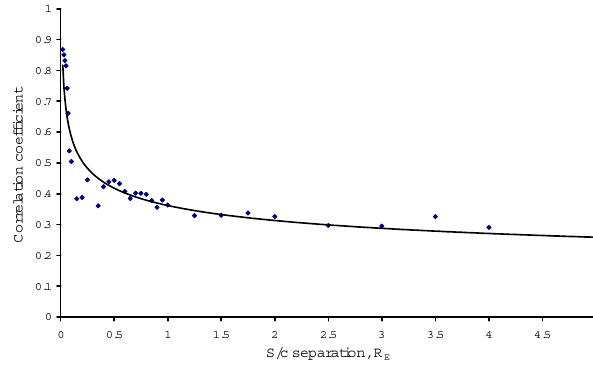
Fig. 8. Averages of cross-correlation coefficients as a function of the s/c separation for a full set of events. The heavy line stands for a power-law fit.